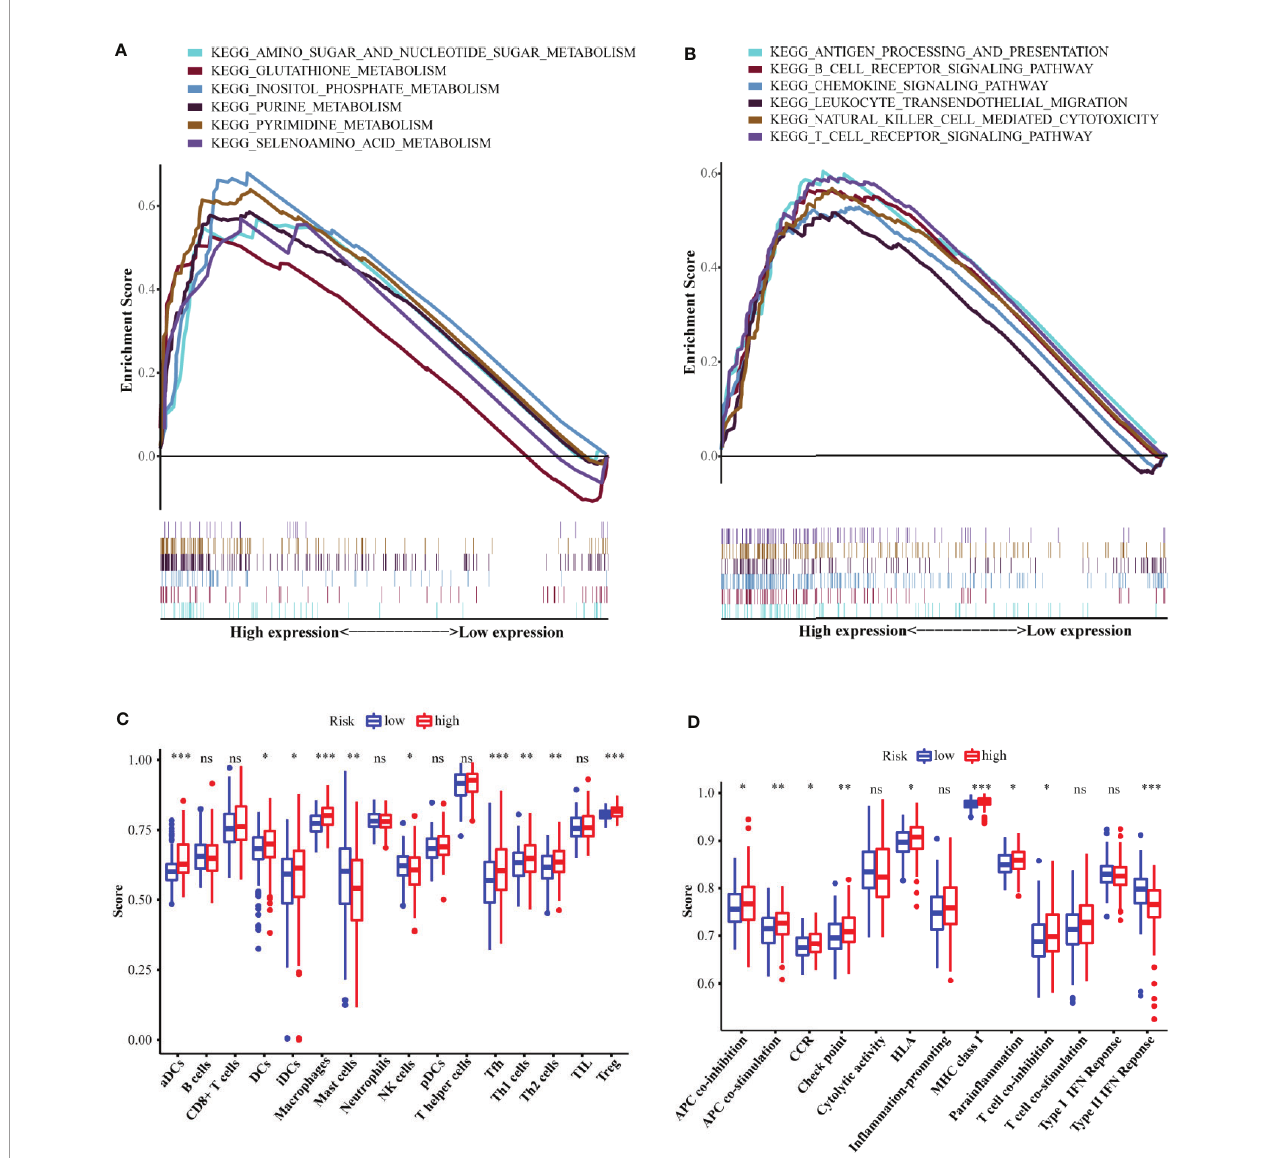
FIGURE 7 | Functional analyses of the low-risk and high-risk groups. The differences of the metabolism-related (A) and immune-related (B) pathways between high- risk and low-risk groups. The scores of 16 immune cells (C) and 13 immune-related functions (D) between the two risk groups. Adjusted P values were showed as: ns, not signi fi cant; * P < 0.05; ** P < 0.01; *** P <